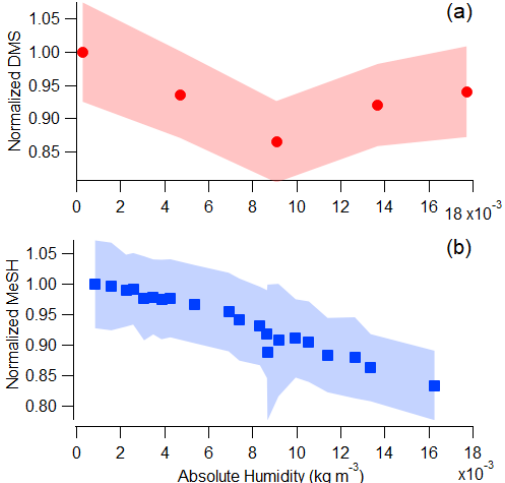
Figure 2. Vocus PTR-ToF-MS signal as a function of absolute hu- midity for a constant flow of (a) DMS (measured at m/Q 63.0263) and (b) MeSH (measured at m/Q 49.0107) in humidified zero air. Absolute humidity values between 0.009 and 0.018kgm − 3 are commonly measured in the MBL in mid-latitude oceans (Liu et al.,